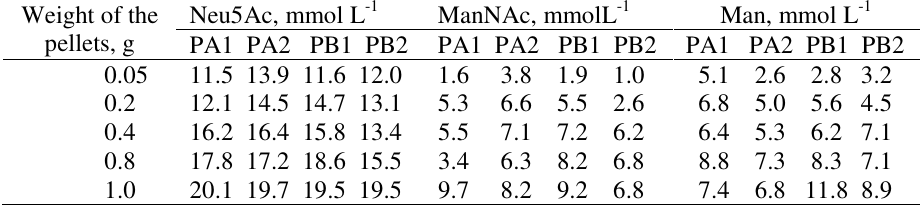
Table 2 . Binding ability to Neu5AC, ManNAc and Man with different weight MIP a (PA1, PA2, PB1 and